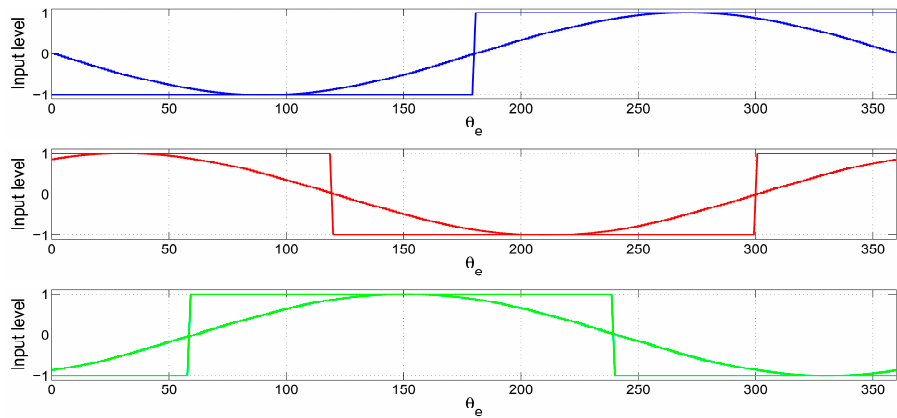
Figure 2. Visualization of a PWM signal having 255 steps to rotate a DC motor to 360 electrical degrees.